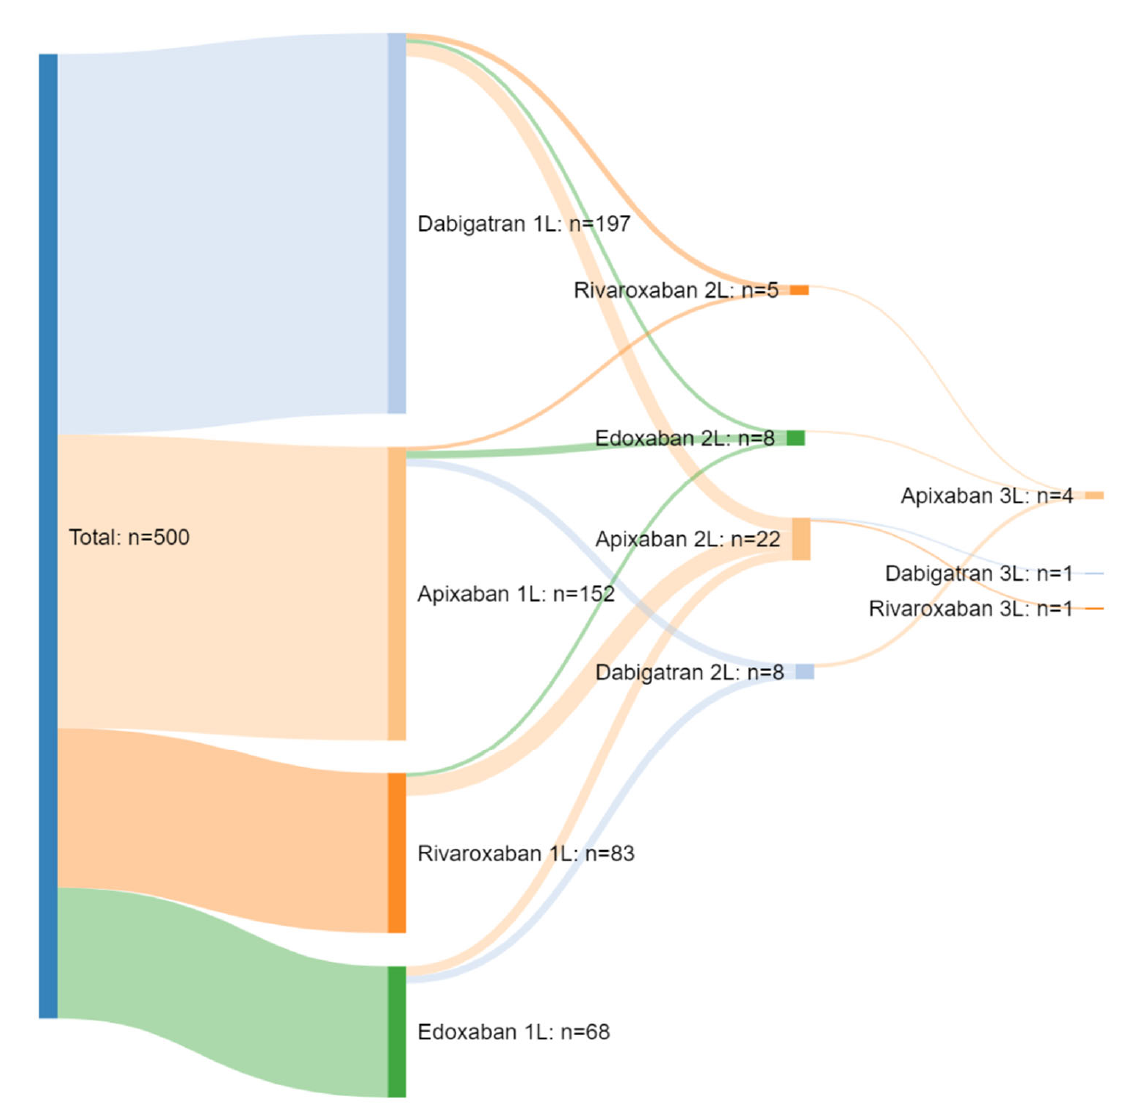
Figure 2. Sankey diagram of NOAC treatment changes. 1L = 1st Line. 2L = 2nd Line (one NOAC switch). 3L = 3rd Line (two NOAC switches). Line refers to the NOAC used prior to switching to